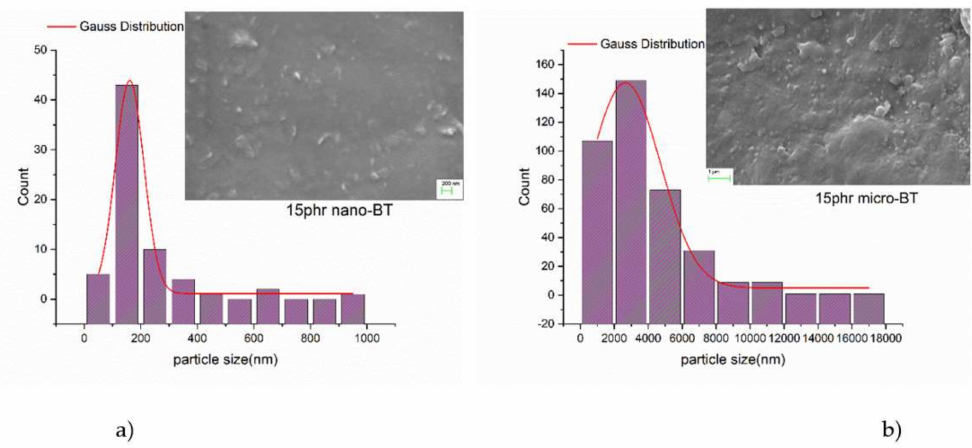
Figure 1. The particles’ size dispersion along with the Gaussian distribution function for ( a ) 15phr micro-BT and ( b ) 15 phr nano-BT / epoxy composite. Insets present representative SEM